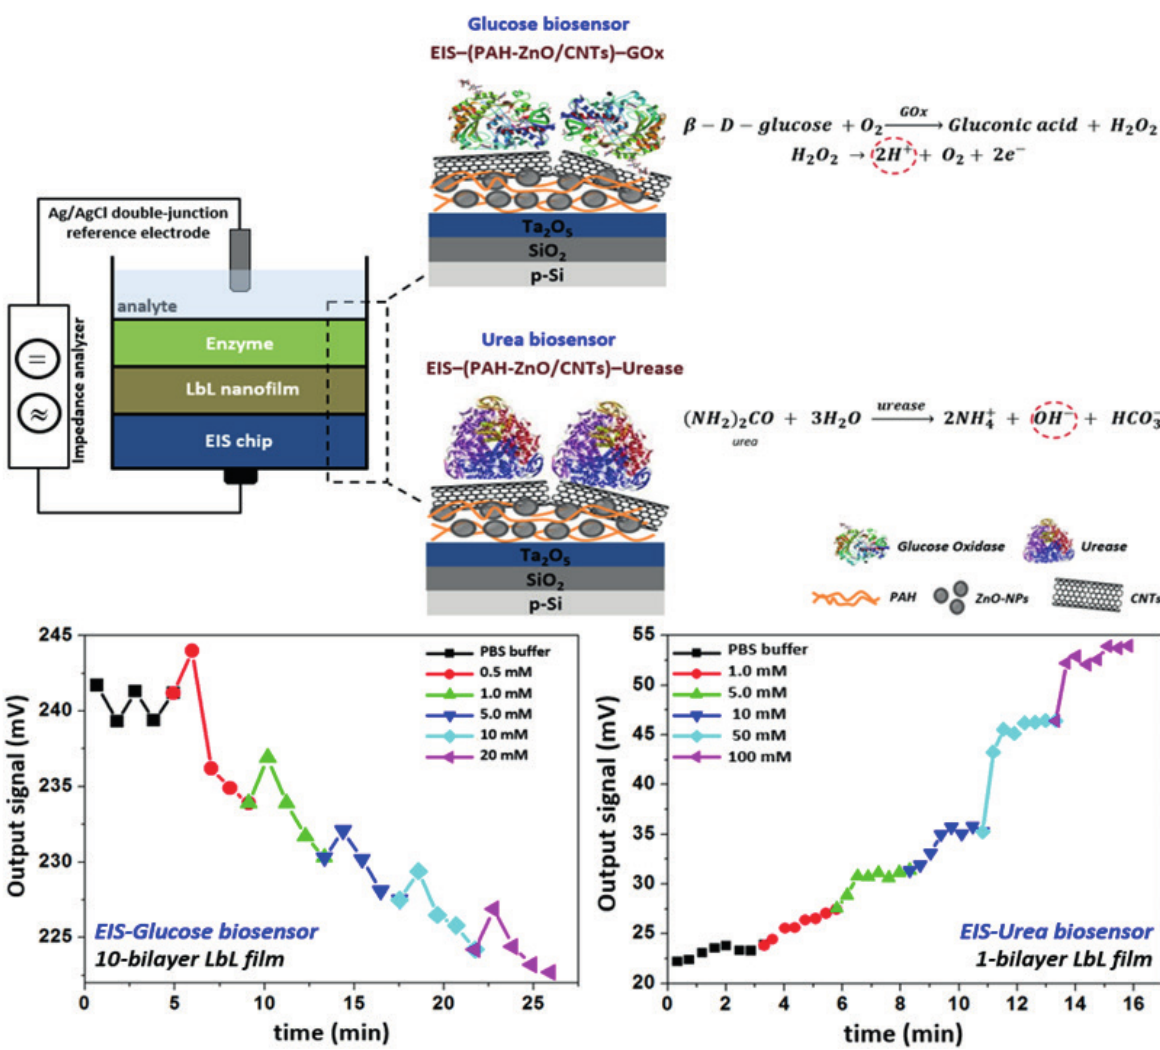
–Ta O ) sensor modified with PAH-ZnO/CNTs LbL film, including the 2 2 5